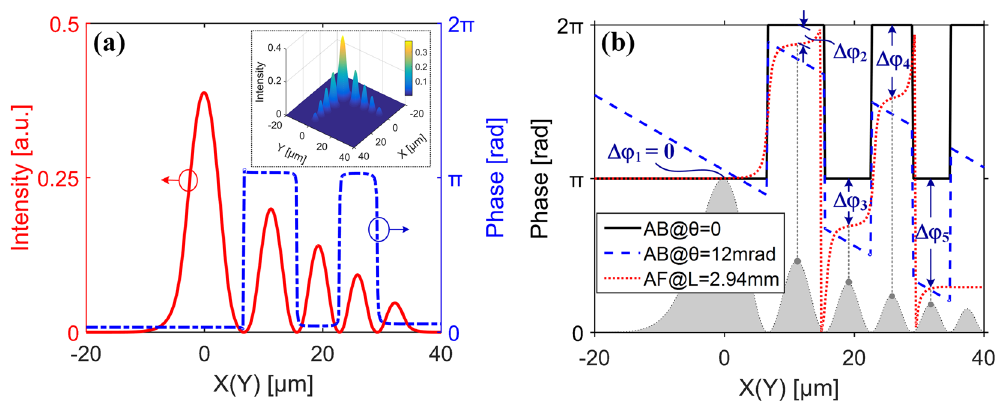
Figure 3. Supermode properties of the Airy fiber. ( a ) The modal amplitude ′ a β ′